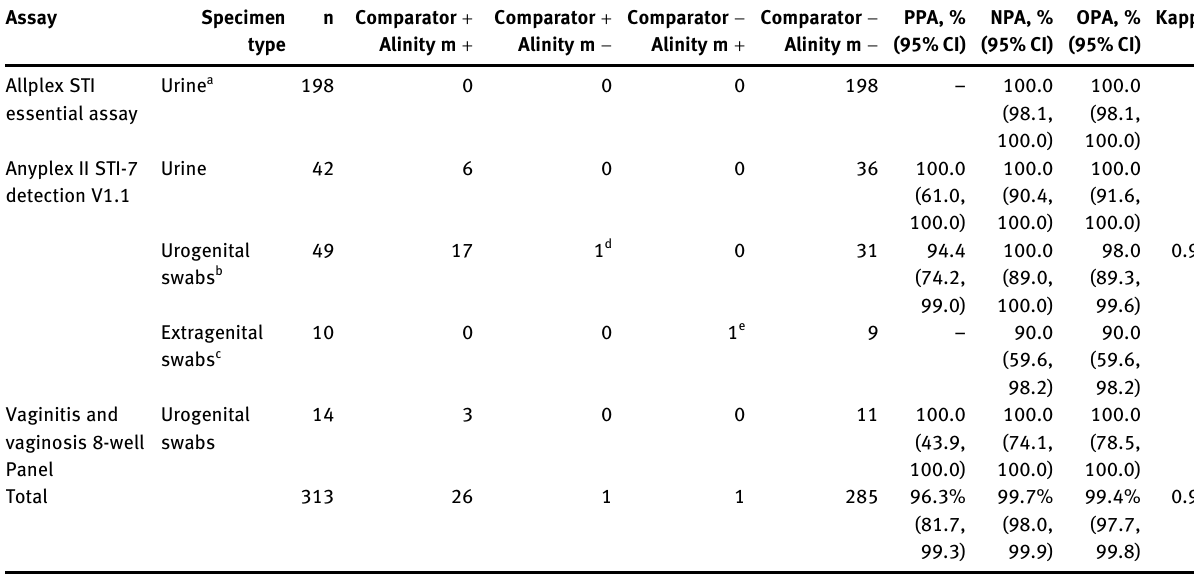
Table  : Performance of the Alinity m STI assay and comparator assays for T. vaginalis. Assay Specimen type Allplex STI essential assay Anyplex II STI-  detection V  .  Urogenital swabs